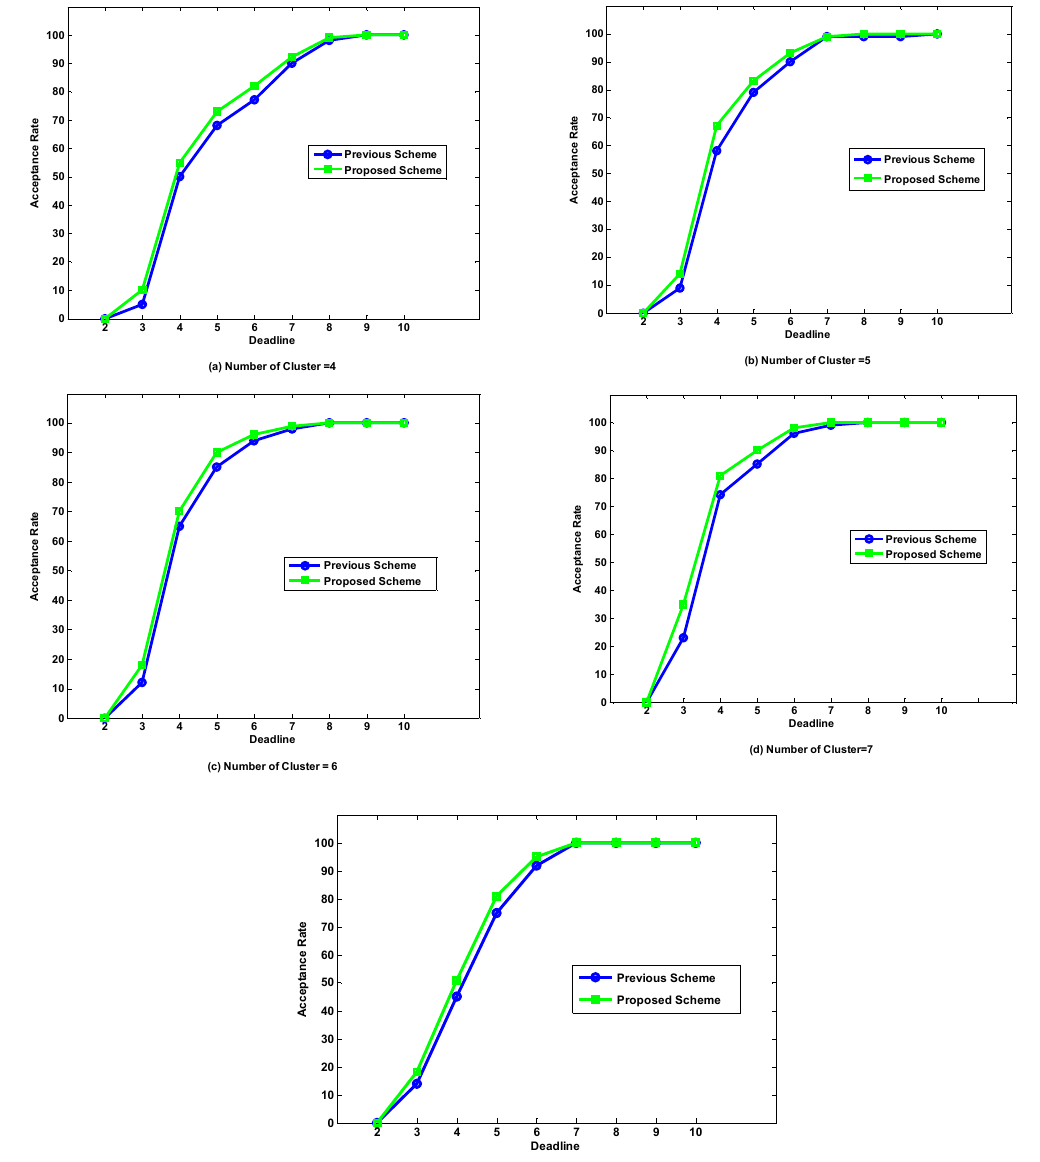
Figure 6. Simulation results for w.r.t Clusters.